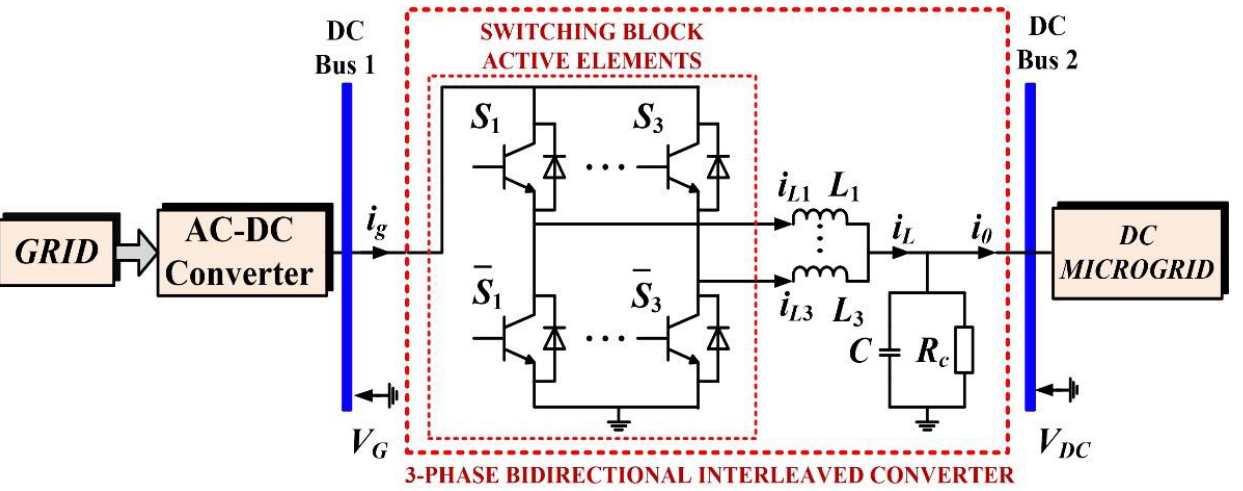
Figure 1. Block diagram of the three-phase power electronic converter.